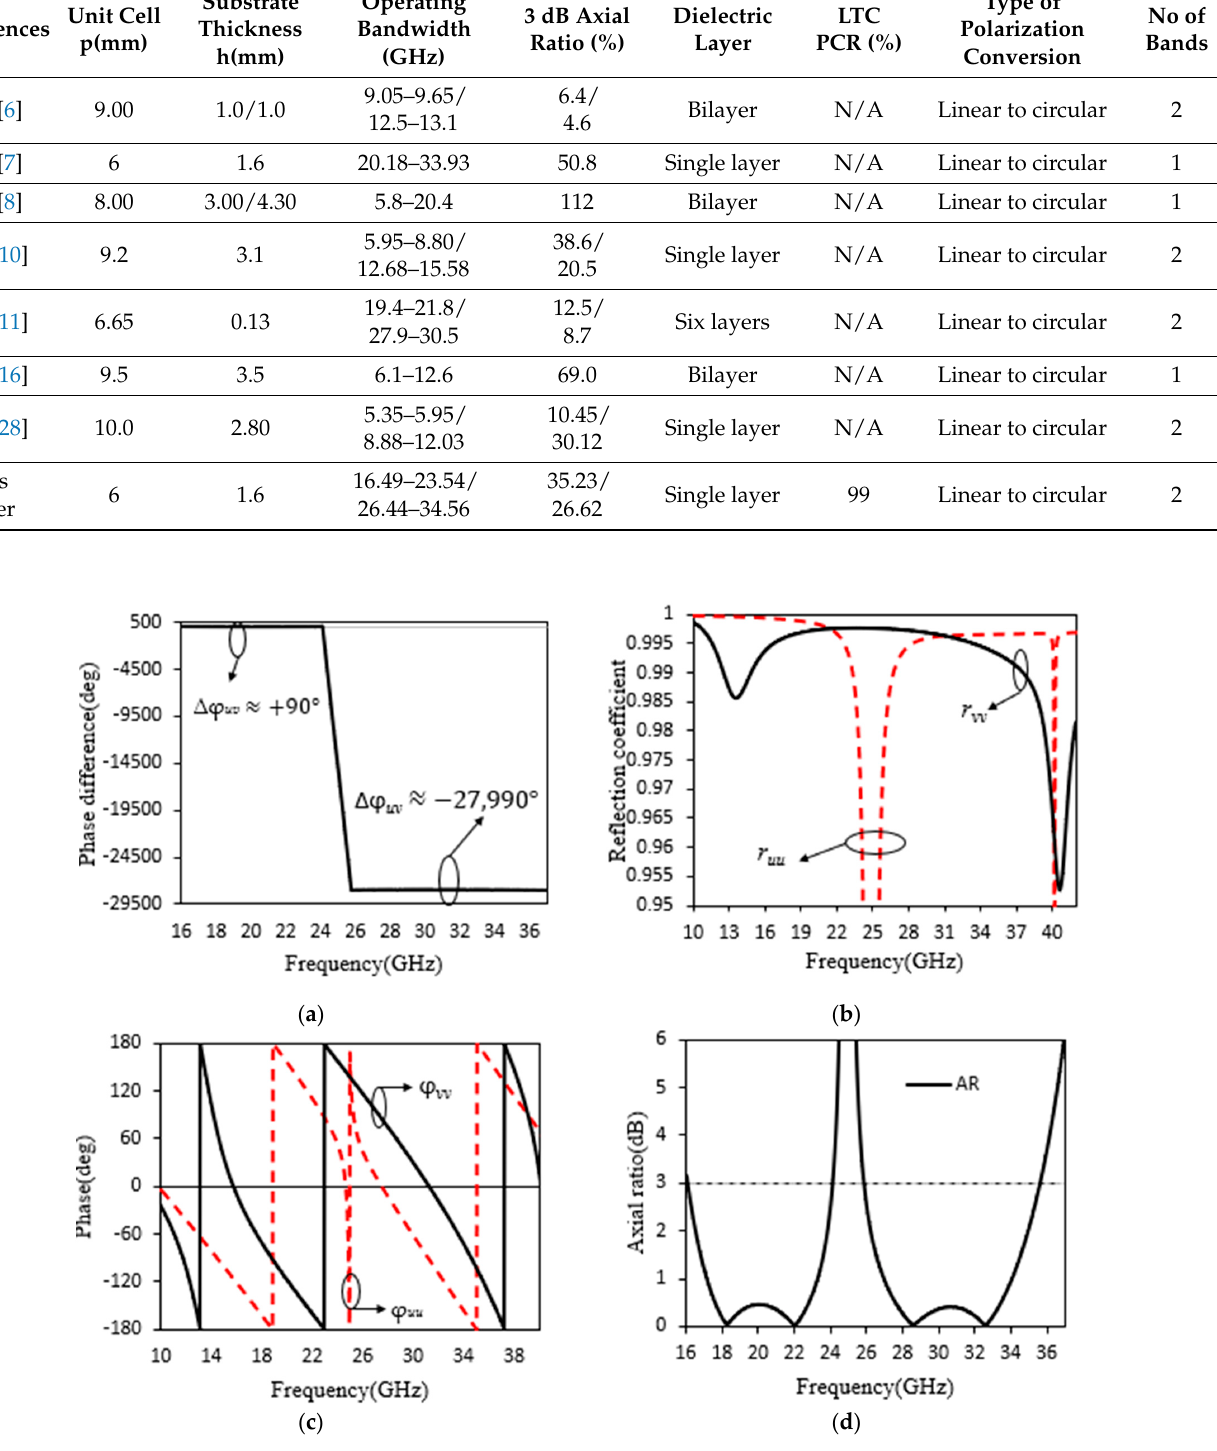
Figure 7. The simulated results of the proposed converter at u -and v -polarized incidences. ( a ) Phase difference ( ∆ ϕ uv ); ( b ) The magnitudes of r uu and r vv ; ( c ) Phase ( ϕ uu and ϕ vv ); ( d ) Axial ratio